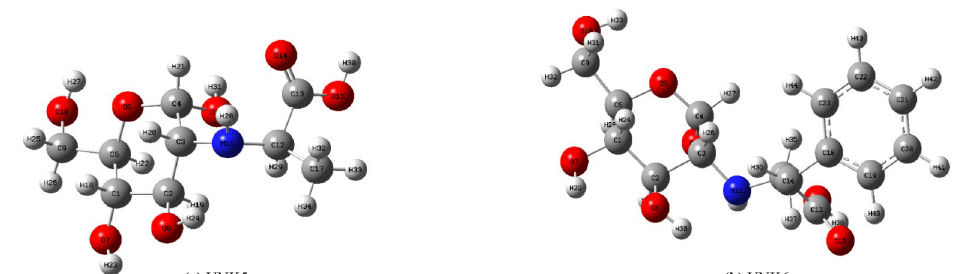
Figure 3. Optimized geometries of the lowest energy conformers of the suggested drugs based on carbohydrate and amino acids at B3LYP/6 ‐ 311++G (d, p) level (see Table 1 for nomenclatures and codes of